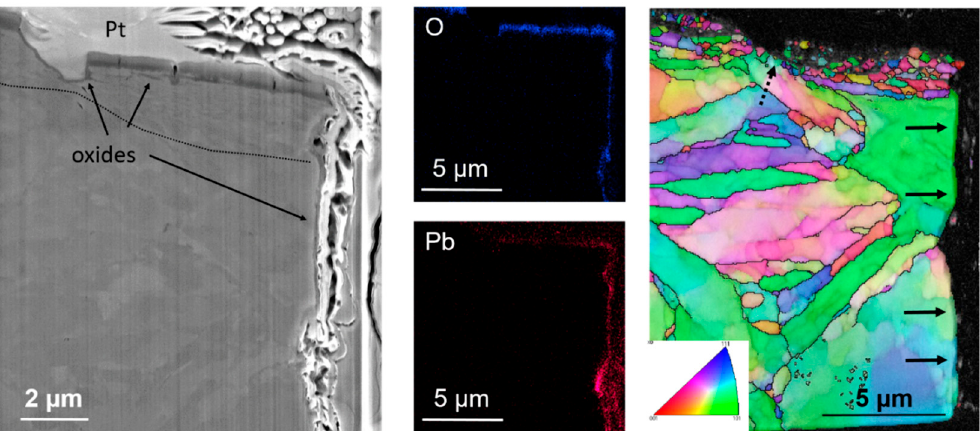
Figure 6. Secondary electron image ( left ) of the upper left part of the crack showing the complex double-oxide layer. Oxide veinlets penetrate into the nanocrystalline subsurface layer, marked with the dashed line. EDS maps of O and Pb illustrate the oxide formation on the surface and walls of the crack on the steel-LBE contact ( middle ). EBSD orientation map (TD inverse pole figure color coding) with high-angle grain boundaries is highlighted. The main crack path is indicated by black arrows. In the area marked with dashed arrows the shallow micro-crack reaches the underlying martensitic laths ( right ).